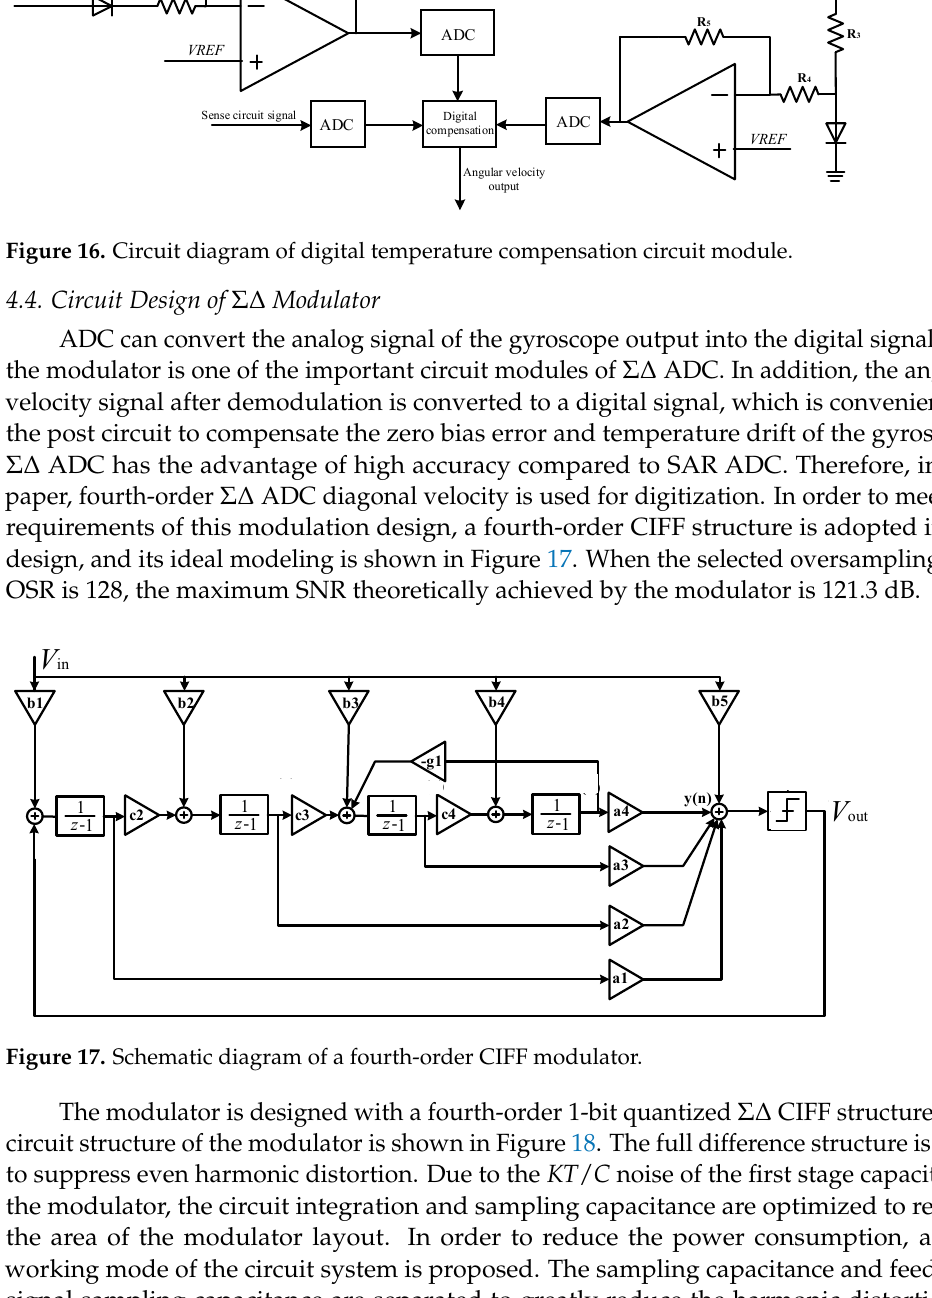
Amp4 Figure 18. Circuit diagram of a fourth-order CIFF ΣΔ modulator. By inputting the AC signal source to the modulator circuit, the modulator is simu- lated at the transistor level. The input power supply voltage of the modulator is 5 V, and the clock frequency is 2 MHz. After simulation, the number of sampling points is 65,536, and the chop frequency of the op-amp is 500 kHz. The signal bandwidth is 7.8 kHz, and the input signal amplitude is 2 V. The frequency is 2.01 kHz sinusoidal signal. Figure 19 shows the output power spectral density of the modulator. The ΣΔ modulator noise floor is about − 135 dB/ √ (Hz), signal-to-noise distortion ratio is − 111.56 dB, and the performance of the modulator meets the design requirements.